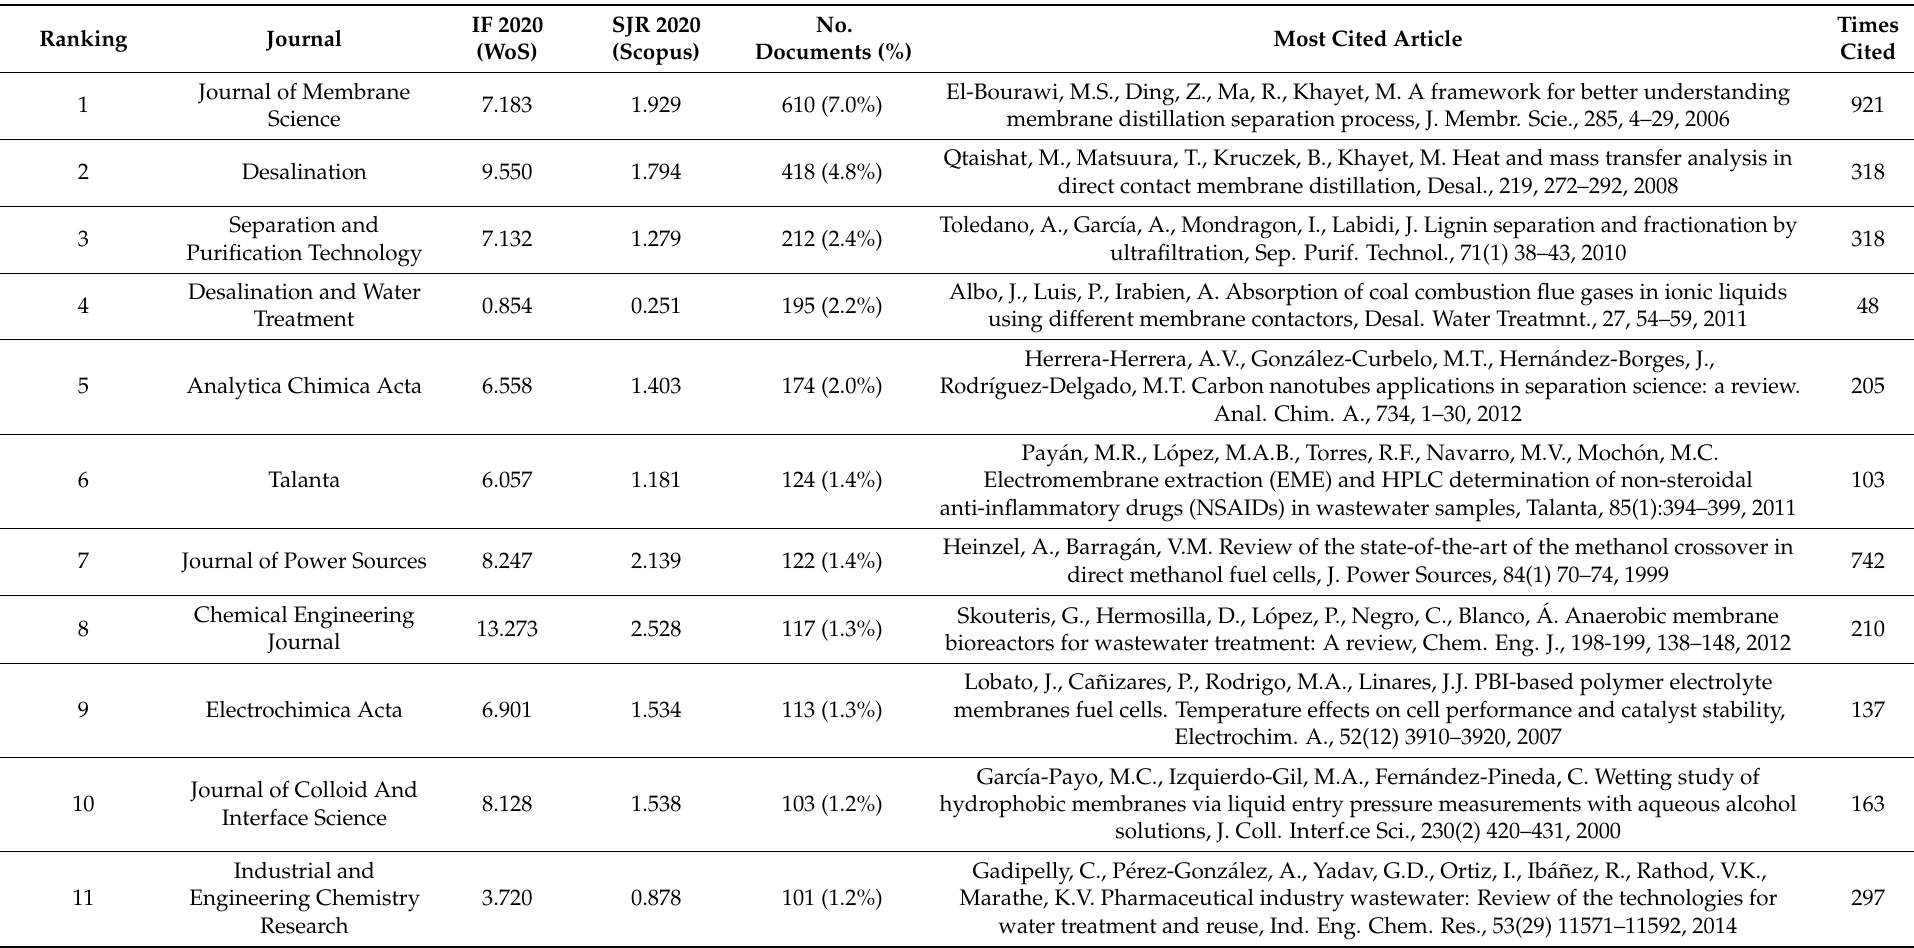
Table 2. The top most productive journals in Figure